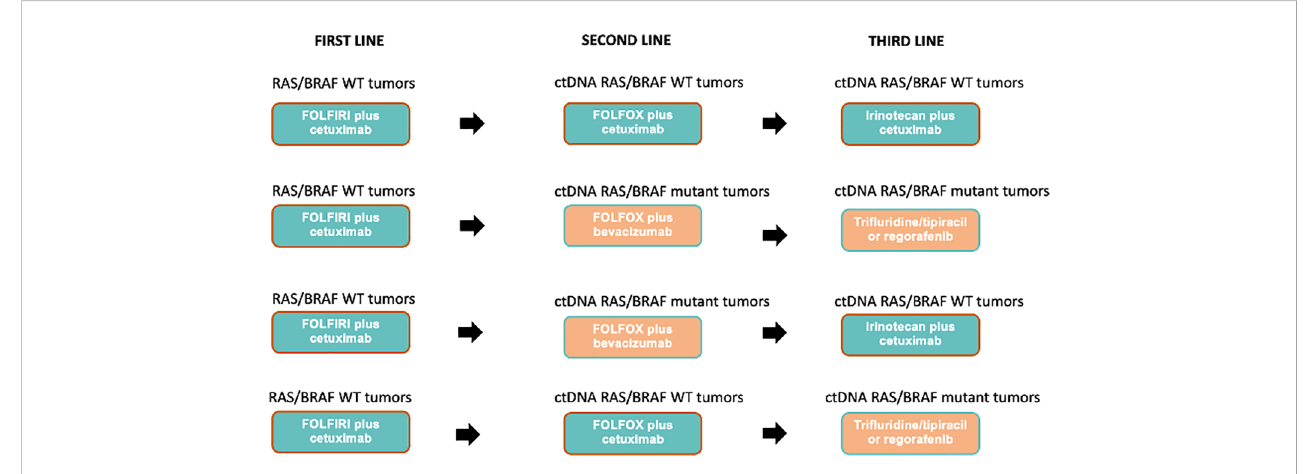
FIGURE 2 Possible treatment sequences based on ctDNA plasma